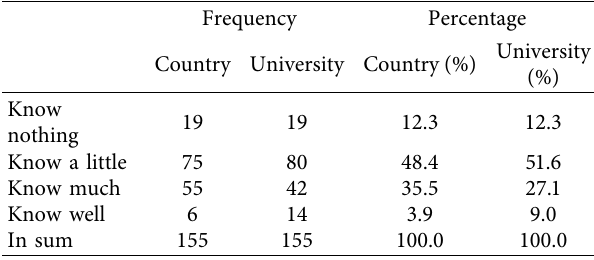
Figure 2: The subjects duration abroad. Table 1: Extents the SISs know about the host country and university.